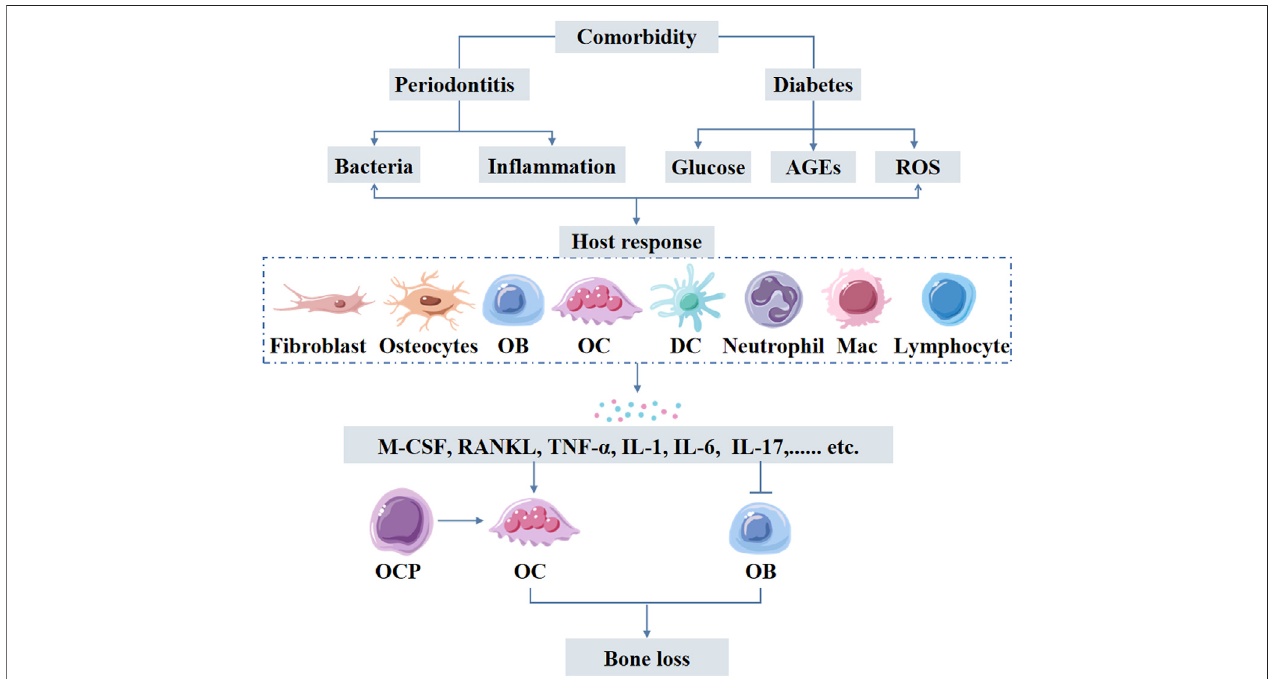
FIGURE4| Periodontitis-diabetes comorbidityinduceshost response triggeringtherelease ofin fl ammatory mediatorsform variety ofcellsincluding immunecells. Elevated levels of in fl ammatory mediators cause both local and systemic effects. In fl ammatory mediator-induced osteoclastogenesis and compromised osteoblast function are the main causes of excessive alveolar bone loss in periodontitis-diabetes comorbidity. AGEs: advanced glycation end products; ROS: reactive oxygen species; OB: osteoblasts, OCP: osteoclast precursors; OC: osteoclasts; DC: dendritic cells; Mac: Macrophages.